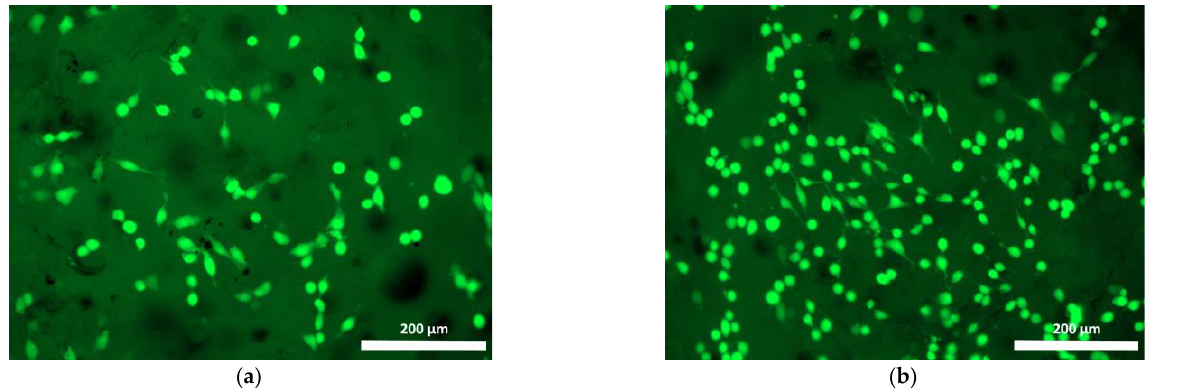
Figure 6. Viable fibroblasts on the surface of specimen of Composition 1 (staining fluorochrome — Calcein AM, BD Pharmingen ™ ; mag.100×): ( a ) 24 h cultivation; ( b ) 72 h cultivation.